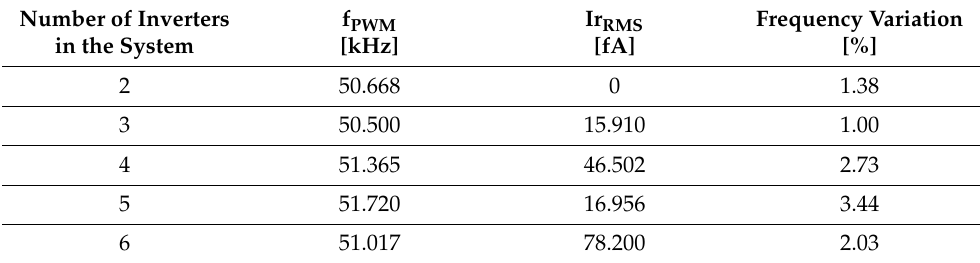
Table 3. Inverters’